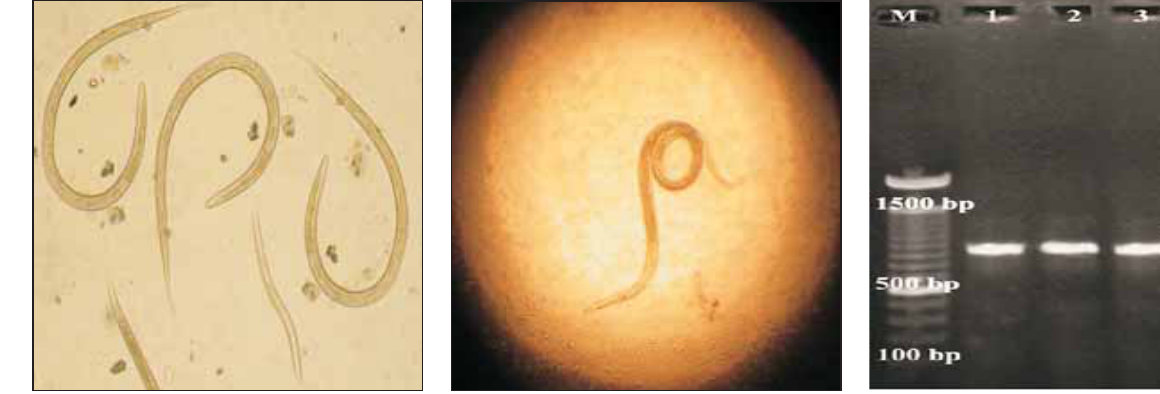
H. contortus Figure-2: ExsheathedL of Figure-1: L larvae of 3